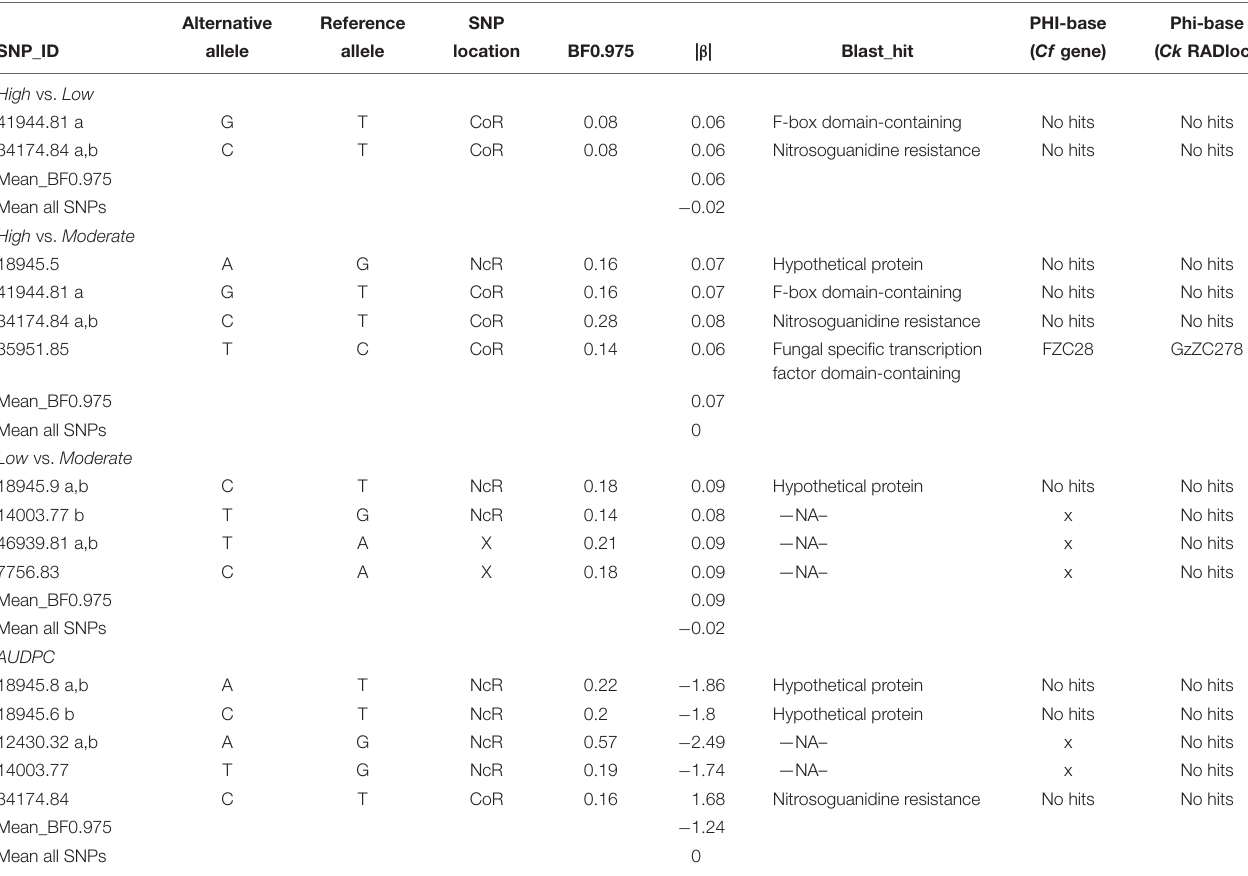
TABLE 1 | SNPs associated with aggressiveness for each pairwise comparison ( High vs. Moderate , High vs. Low , Low vs. Moderate ) and for the continuous analyses ( AUDPC ) obtained through Single-SNP association tests using Bayesian regression approach. Alternative Reference SNP PHI-base